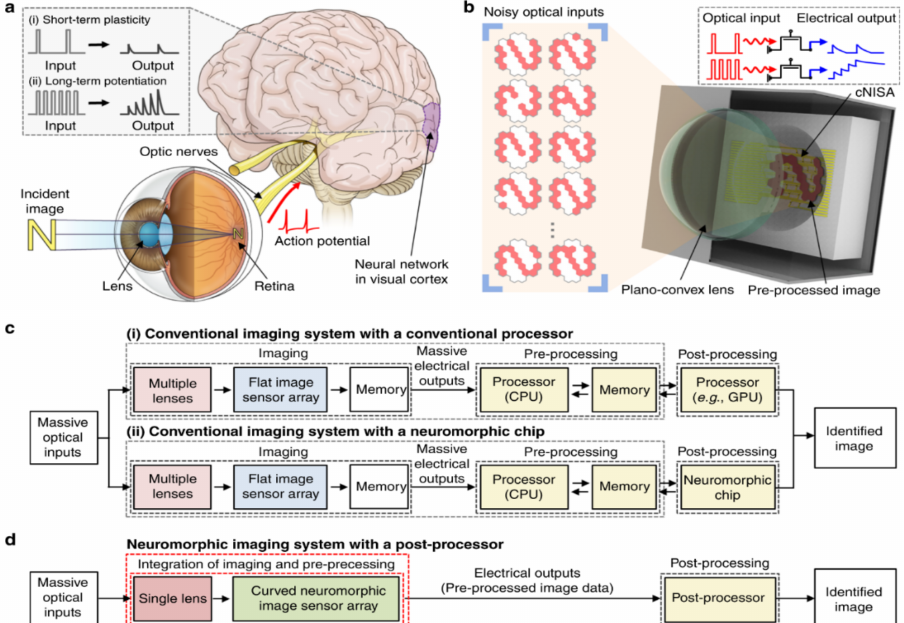
Figure 3. Optical application of MoS 2 . Curved neuromorphic imaging device inspired by the human visual recognition system. ( a ) Human visual recognition system ( b ) Curved neuromorphic imaging device ( c ) Block diagram of conventional imaging system ( d ) Proposed Curved neuromorphic imaging system. Reproduced from [84]. Springer Nature